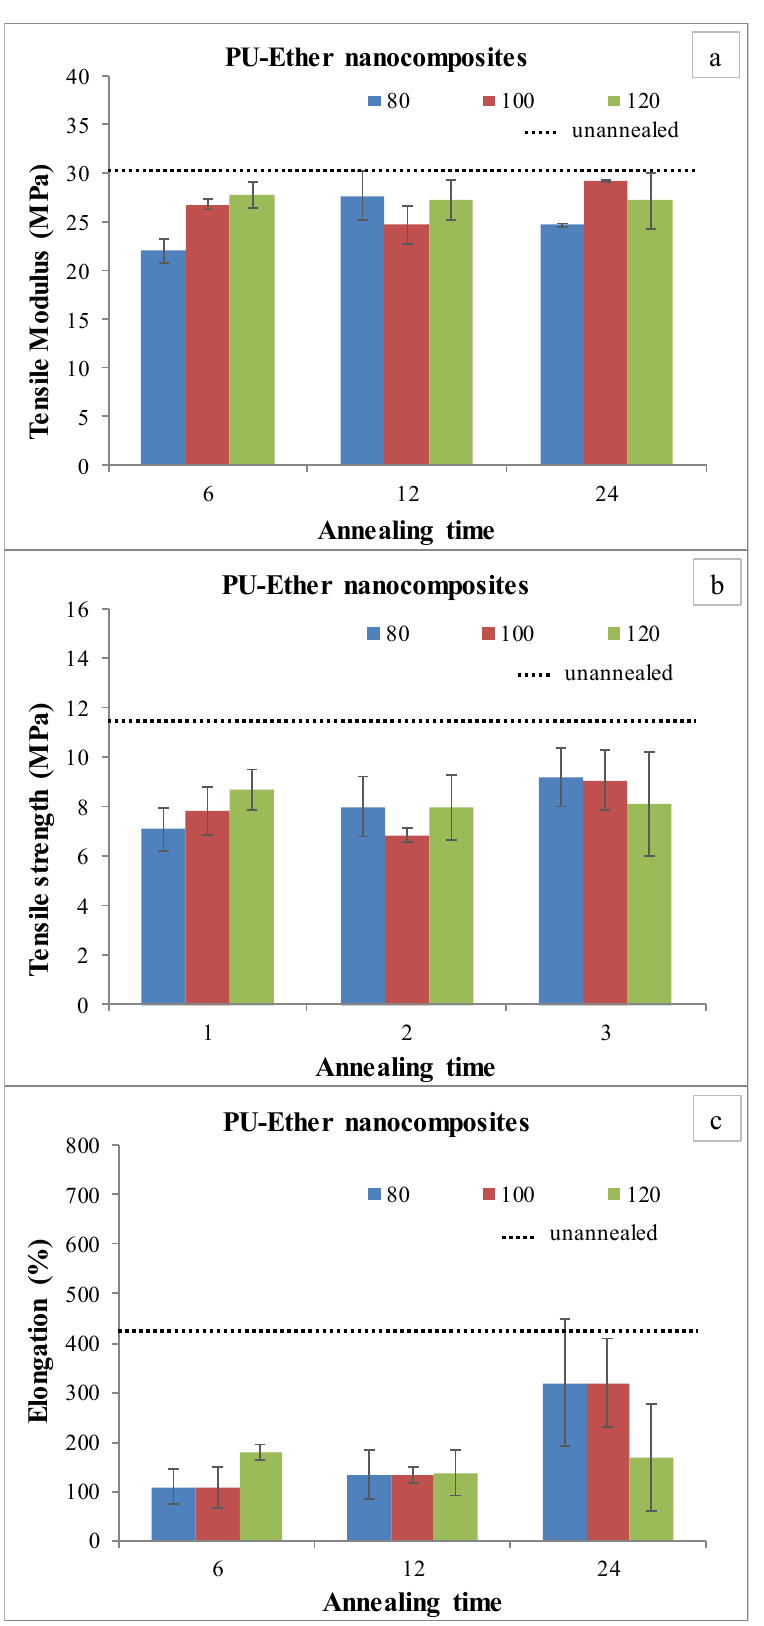
Figure 3 . Tensile testing of annealed PU - Ester / MWCNT nanocomposites; tensile modulus ( a ) , tensile strength ( b ) and elongation at break ( c ) .